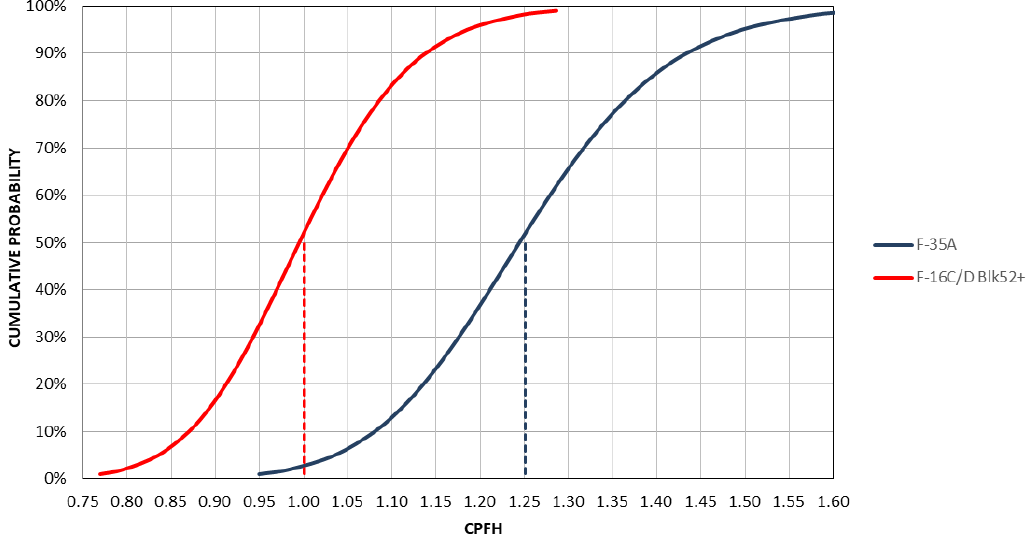
Figure 11. The cumulative distribution for the F-35A CPFH compared to the F-16C/D Block52+, according to the developed parametric model.